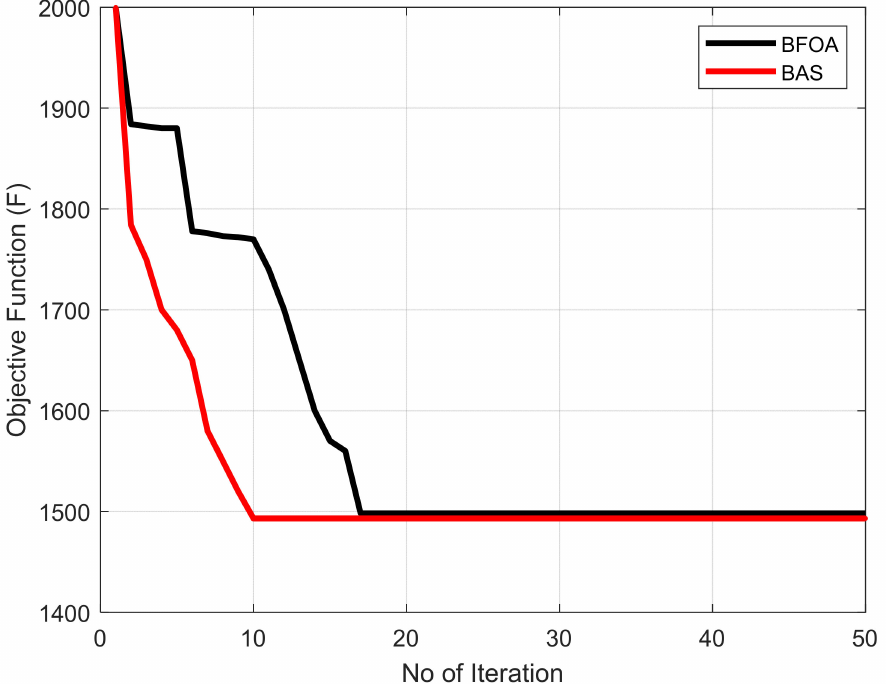
Figure 14. Comparison of the convergence characteristic of the objective function with different algorithms